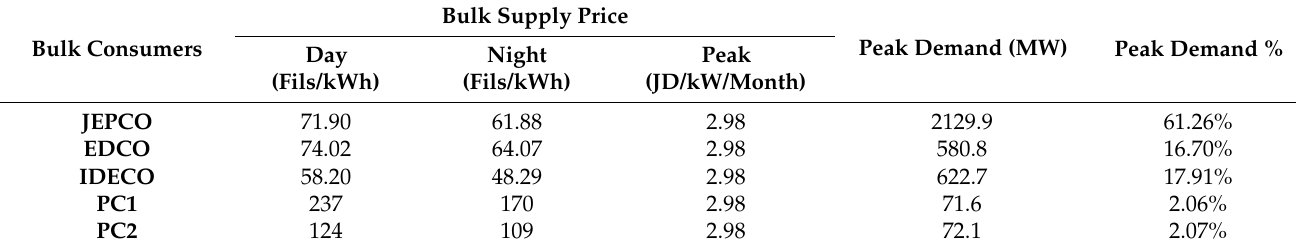
Table 3. Bulk supply prices and peak demand 2019.